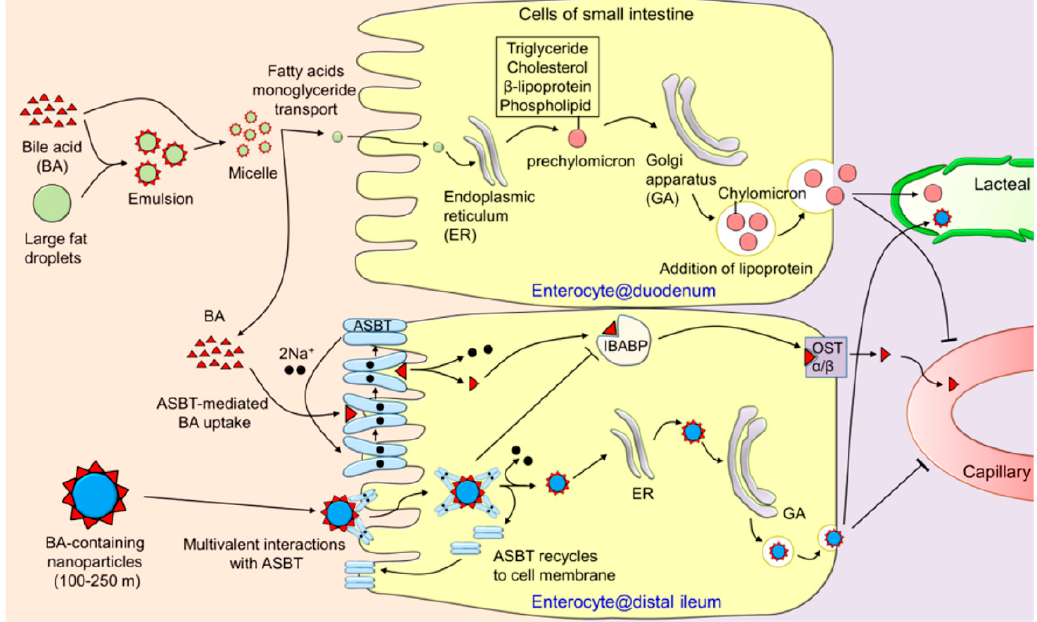
Figure 3. After oral administration, the bile acid-conjugated nanoparticles are endocytosed into enterocytes at the distal ileum via multivalent interaction with ASBT and subsequently appear in the systemic circulation via the lymphatic system. Reproduced with permission from [49]; Copyright 2018 American Chemical Society.